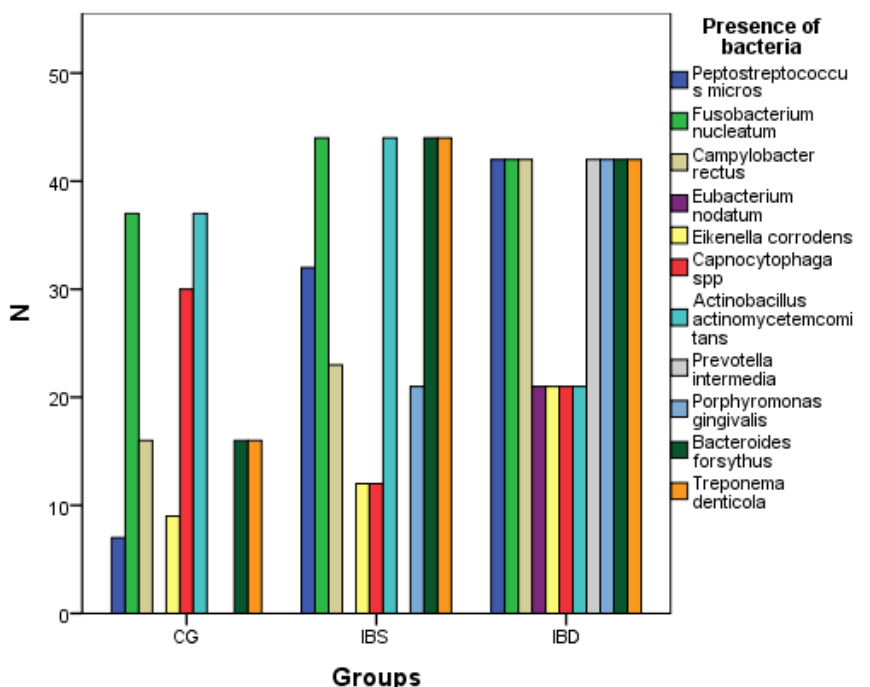
Figure 4. Graphical presentation of the number of patients in the three research groups.